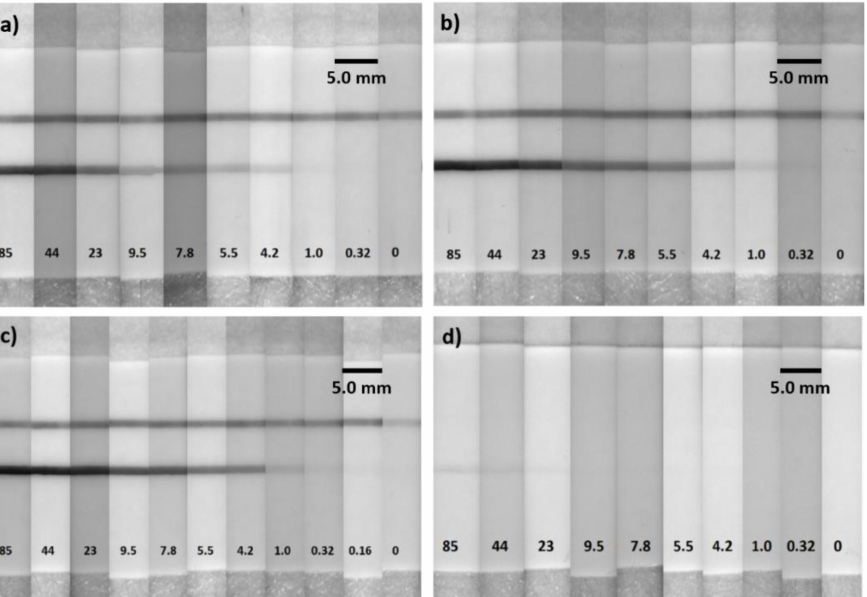
Figure 5. Representative photographs taken from the 150 nm gold-nanoshell-based LFAs with 10 ( a ), 25 ( b ), and 50 ( c ) µ L of TSH calibrators. ( d ) Representative photographs taken from the 40 nm gold-nanoparticle-based LFAs with 50 µ L of TSH calibrators.